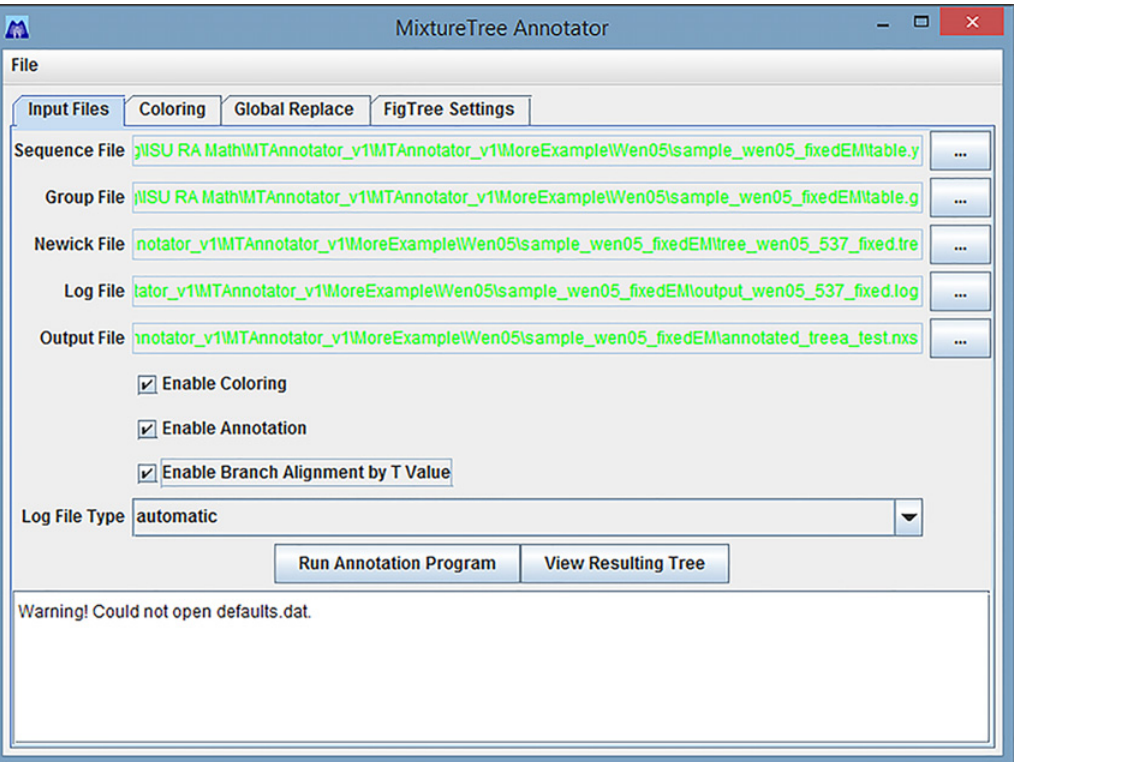
Fig 5. An Example of Entering External Files Generated from